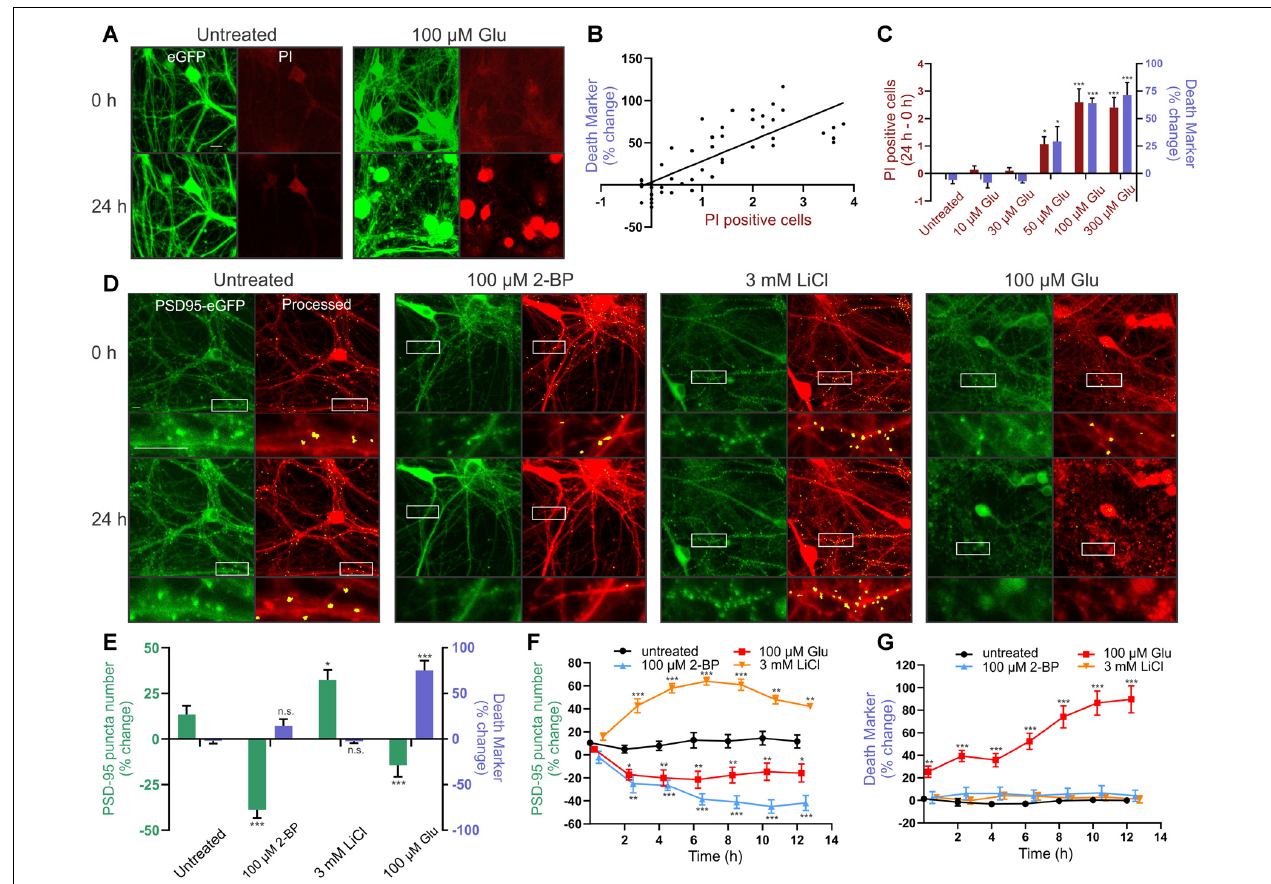
FIGURE 3 | Reliable detection of synaptic changes and cellular toxicity in rat hippocampal cultures. (A–C) Cultures were transduced with AAVPHP.eB-hSyn-eGFP and imaged in the presence of 5 µ g/ml propidium iodide (PI). (A) Representative images show eGFP (green) and PI (red) fluorescence before (0 h) and after (24 h) no treatment (untreated) or treatment with 100 µ M glutamate (Glu). Scale bar: 10 µ M. (B) The death marker (particle number) determined from the eGFP binary image correlated with the number of PI-positive cells in the same field (Linear regression; r ( 46 ) = 0.6351, p ≤ 0.0001, n = 36 wells). (C) Glutamate elicited a concentration-dependent increase in the death marker (particle number; purple bars) and number of PI-positive cells (red bars) over the course of 24 h (Kruskal–Wallis test; K–W statistic = 25.68, p ≤ 0.0001 for particle number. Kruskal–Wallis test; K–W statistic = 27.36, p ≤ 0.0001 for number of PI-positive cells, n = 6 wells per group). (D,E) Cultures were transduced with HdAd-hSyn-PSD95-eGFP-hSyn-mCherry. (D) Representative images show PSD95-eGFP (green) and the processed overlay (puncta in yellow, mCherry MIP in red) for ROIs before (0 h) and 24 h following no treatment (untreated) or treatment with 100 µ M 2-BP, 3 mM LiCl, or 100 µ M glutamate. Insets display enlarged images of the boxed regions. Scale bar: 10 µ M. (E) Bar graph displays change in synapse number (PSD95 puncta) and change in death marker (particle number) 24 h after treatment under the indicated condition (nested one way analysis of variance, ANOVA; F ( 3,32 ) = 17.48, p ≤ 0.0001 for particle number, nested one way ANOVA; F ( 3,32 ) = 31.84, p ≤ 0.0001 for puncta change, n = 42 ROIs from nine wells for untreated, n = 41 ROIs from nine wells for 3 mM LiCl, n = 43 ROIs from nine wells for 100 µ M 2BP, n = 40 ROIs from 9 wells for 100 µ M glutamate). (F,G) Time-lapse experiments show change in synapse number (PSD95 puncta) and death marker (red mask particle number) compared to initial baseline images during an automated repeated acquisition experiment. Image values as a percent of baseline are plotted vs. time post-treatment (one-way ANOVA followed by Tukey’s post hoc test; ∗ p < 0.05, ∗∗ p < 0.01, ∗∗∗ p < 0.001 compared to untreated, n = 9 wells per group with five ROIs averaged per well). Data were collected with laser scanning confocal microscopy. ImageJ settings were as follows; Red MIP mask threshold: 0.25 × red MIP mean intensity, Red MIP threshold for particle